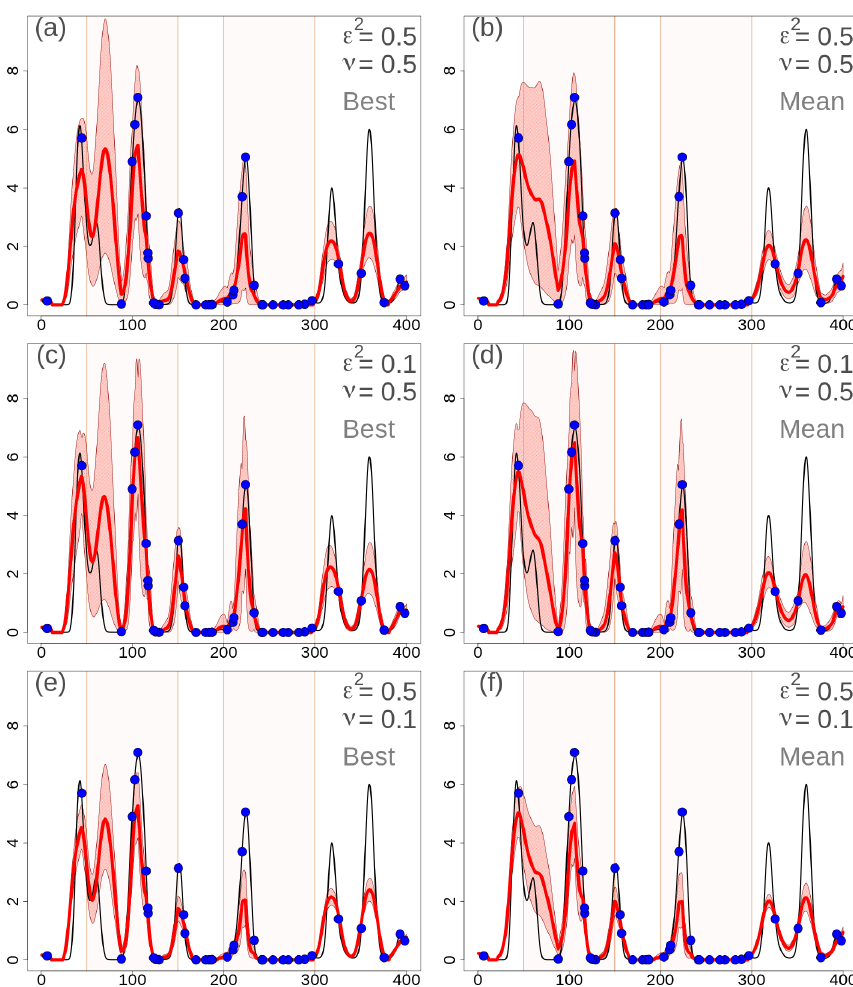
Figure 6. One-dimensional simulation in the original precipitation space (in millimeters). Analyses at grid points with different EnSI-GAP configurations, without considering the whole ensemble. Specification of the scale matrix used. The layout is similar to Fig. 3, except that here (a) , (c) , and (e) show the results obtained when considering the background as the best member of the ensemble, while for (b) , (d) , and (f) the background is the ensemble